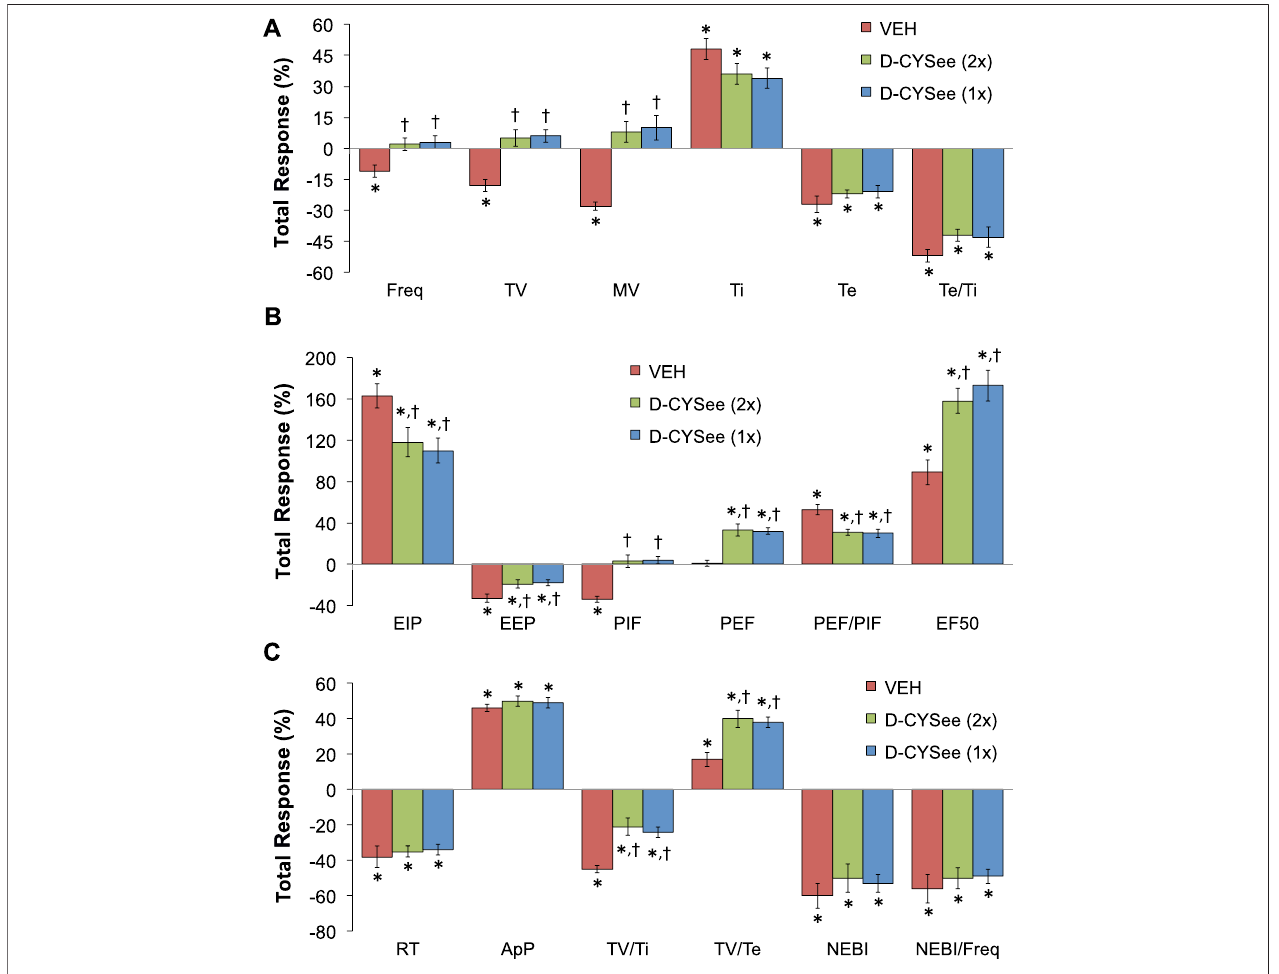
FIGURE5| Totalchanges(expressedas%changefrompre-values) inFreq,TV,MV,Ti,TeandTe/Ti (A) ,EIP,EEP,PIF,PEF,PEF/PIFandEF50 (B) ,andRT,ApP, TV/Ti, TV/Te, NEBI, and NEBI/Freq (C) that occurred over the 15-min period following the fi rst injection of vehicle (VEH, IV) or D-cysteine ethyl ester (D-CYSee, 500 μ mol/kg, IV). The vehicle (VEH) group received two injections of vehicle. The D-CYSee (2x) group received two injections of D-CYSee, whereas the D-CYSee (1x) group received one injection of D-CYSee and then an injection of vehicle. There were 5 rats in the vehicle group and 6 rats in the D-CYSee groups. * p < 0.05, signi fi cant change from pre. † p < 0.05, D-CYSee versus